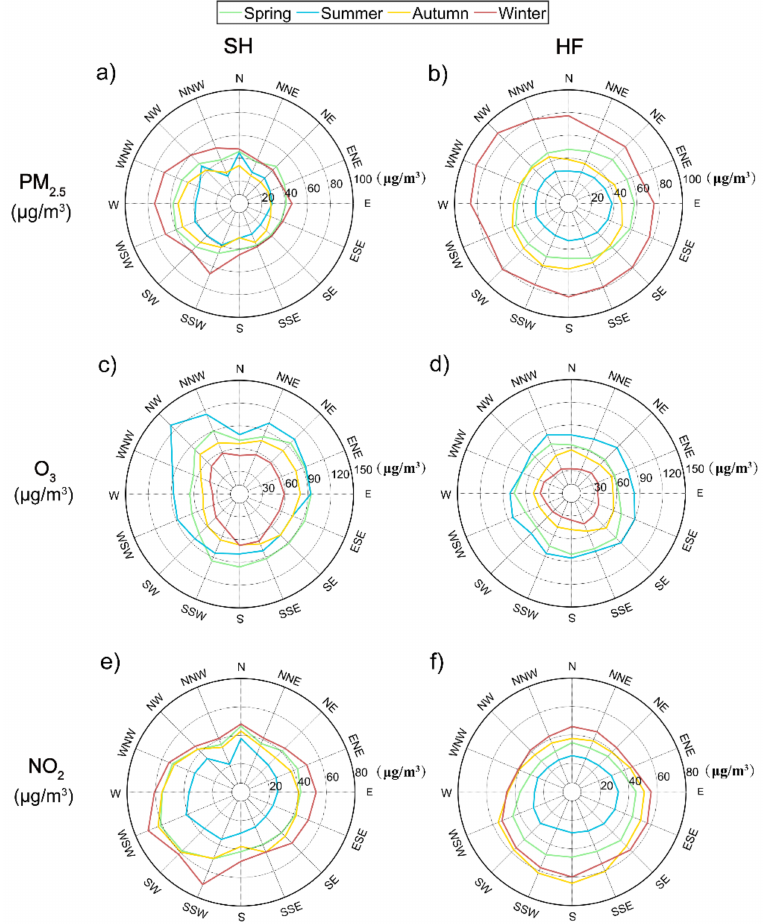
Figure 4. Distributions of seasonal mean concentrations of ( a , b ) PM 2.5 , ( c , d ) O 3 , and ( e , f ) NO 2 in Shanghai (SH, left panels) and Hefei (HF, right panels). The numbers in each panel show the pollutant concentrations (unit: µ g/m 3